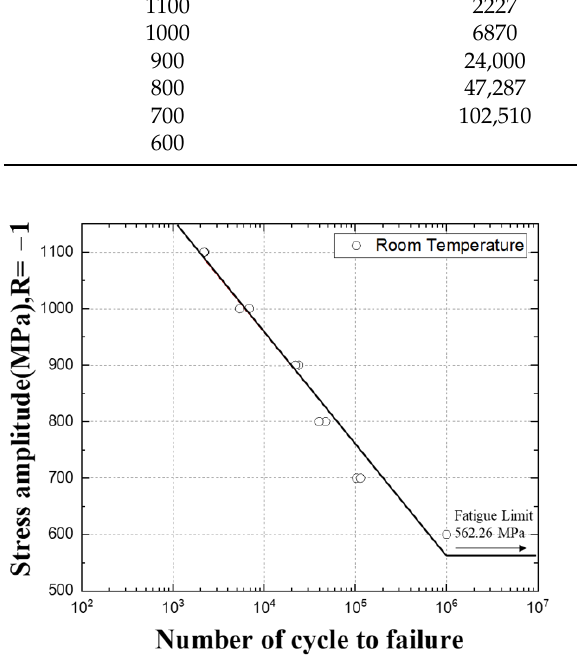
Figure 14. The S–N curve of SKD61.